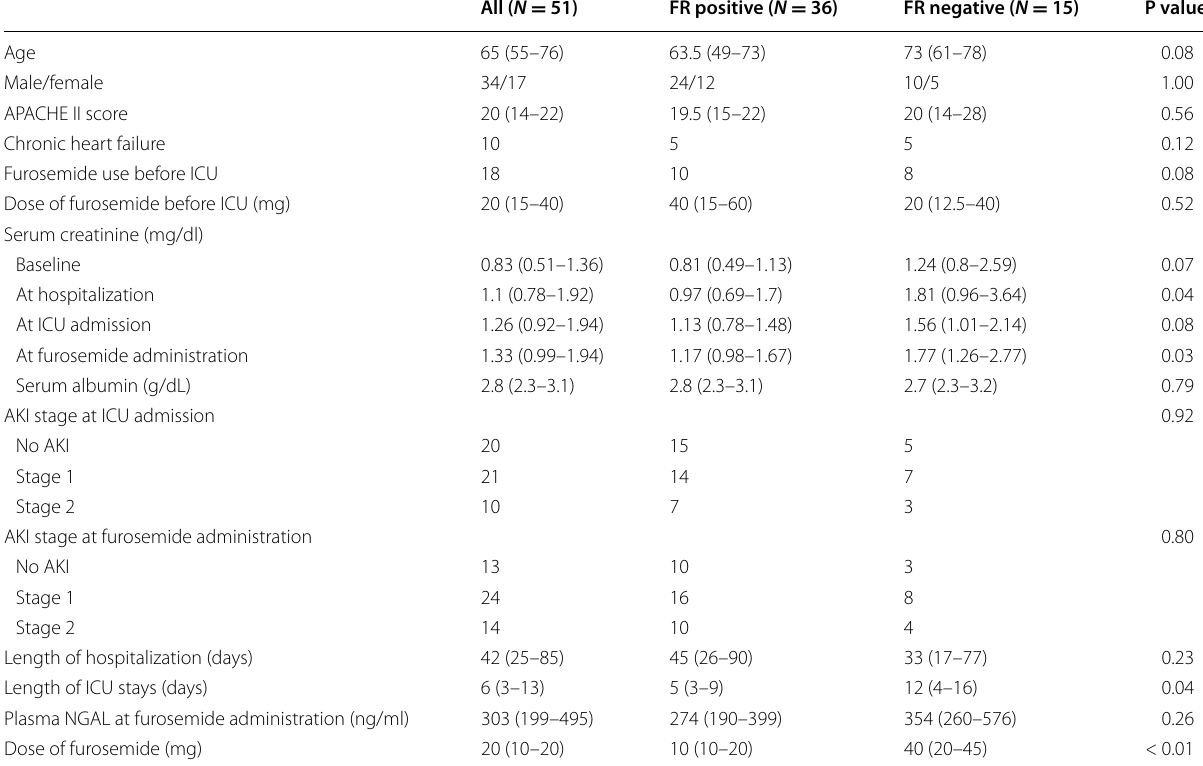
Table 3 Characteristics of patients with high plasma NGAL levels